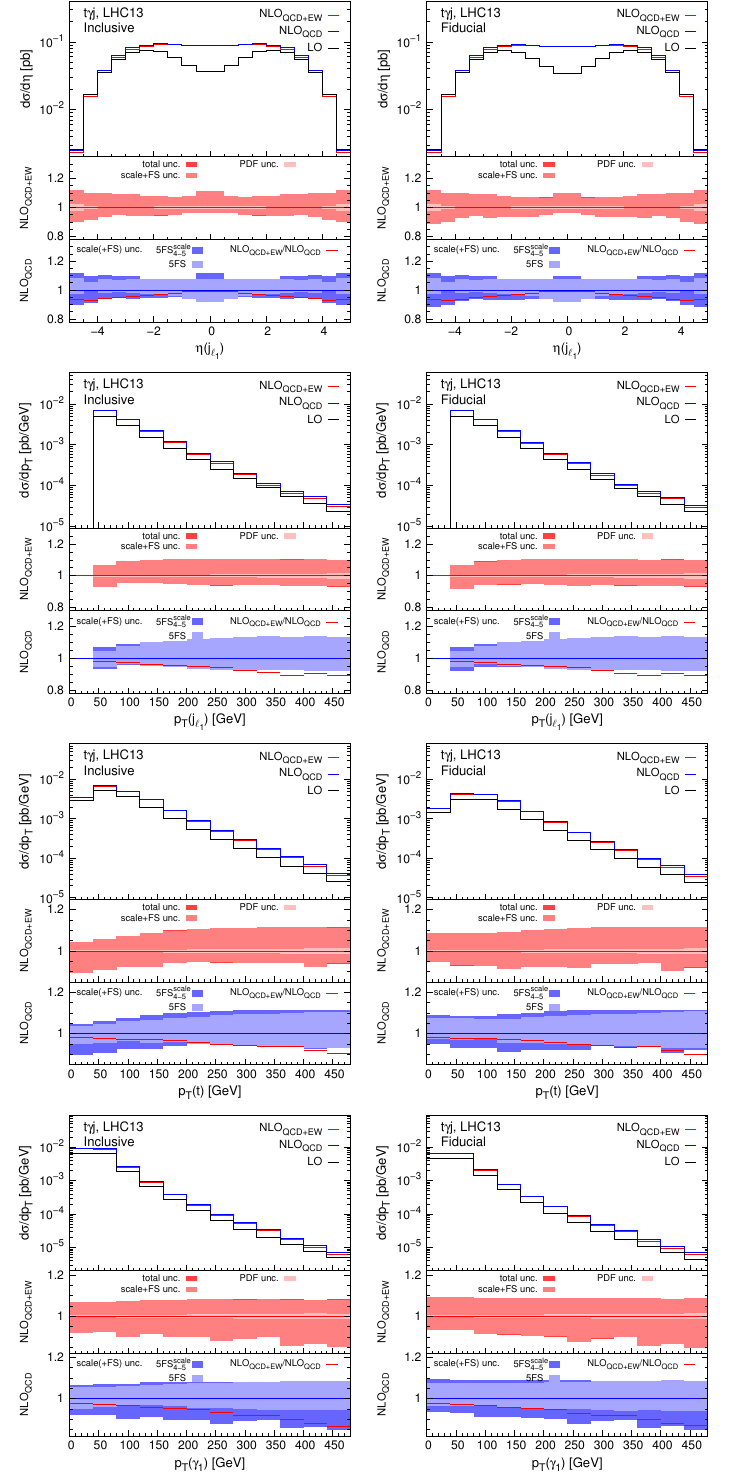
Figure 3 . Differential distributions for tγj